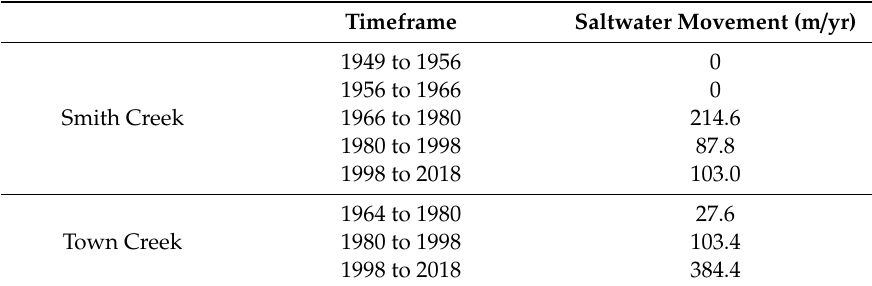
Table 4. Rate (m / yr) of saltwater migration upstream for Smith Creek and Town